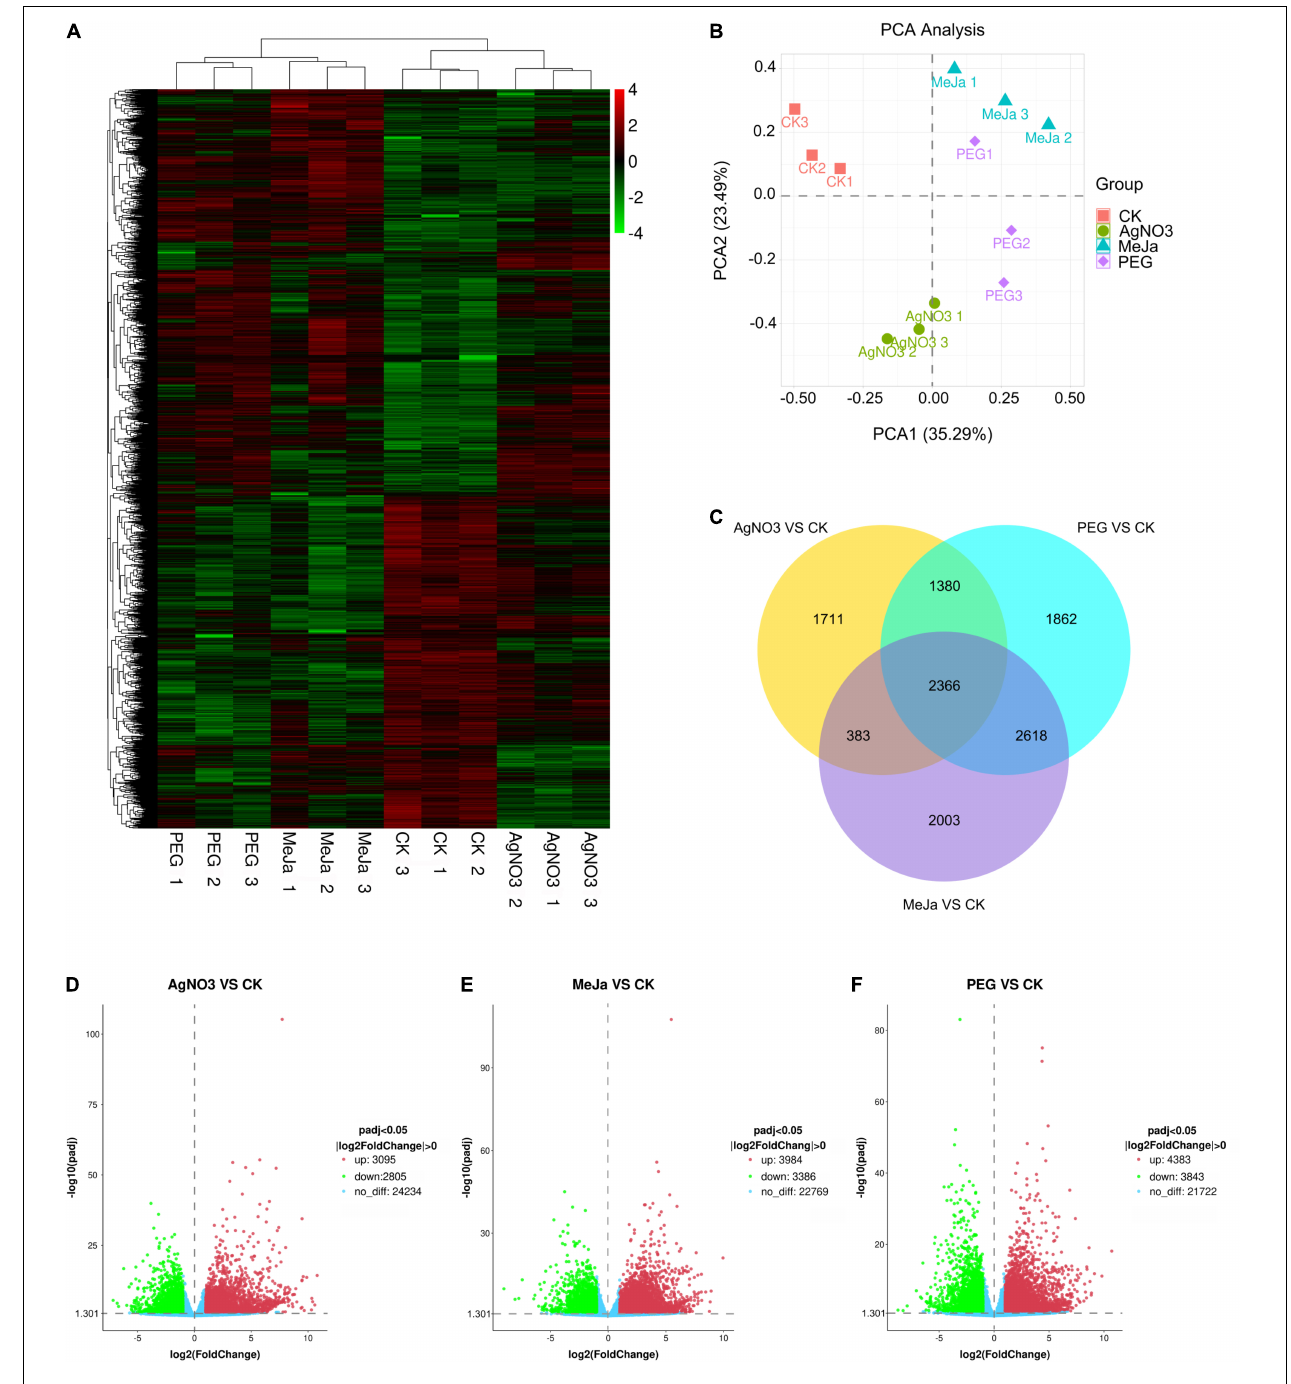
FIGURE 3 | Comparative analysis at the transcriptomic level for the elicitation and control groups. (A) Cluster analyses for gene expression. (B) PCA score plot. (C) Venn diagram. Differential expression analyses: (D) AgNO 3 vs. CK; (E) MeJa vs. CK; (F) PEG vs. CK. MeJa, methyl jasmonate; AgNO 3 , silver nitrate; PEG, polyethylene glycol-20000; CK, control